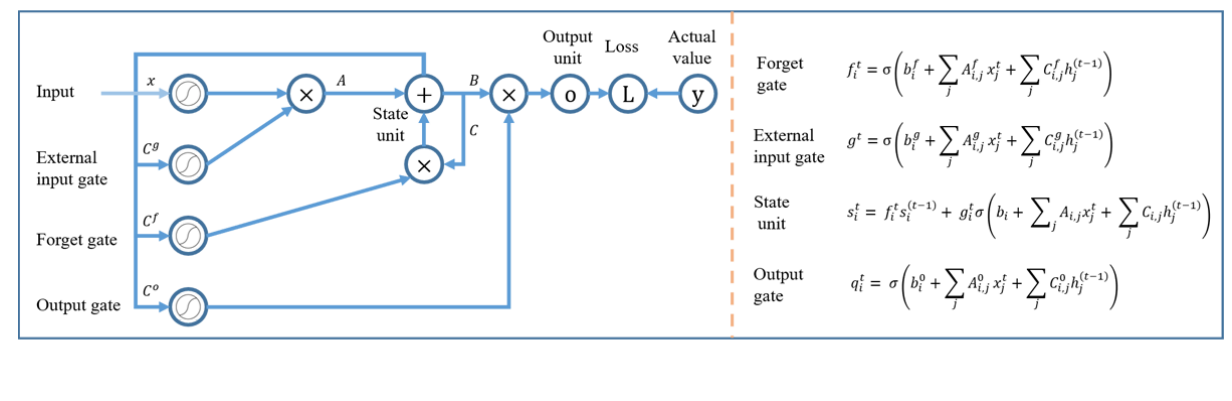
Figure 5. Block diagram of the LSTM neural network, where the left portion of the figure shows how an LSTM regulates the information flow using the three control gates and the right portion provides the mathematical equations for the key gates and units of the LSTM model. LSTM: long short-term